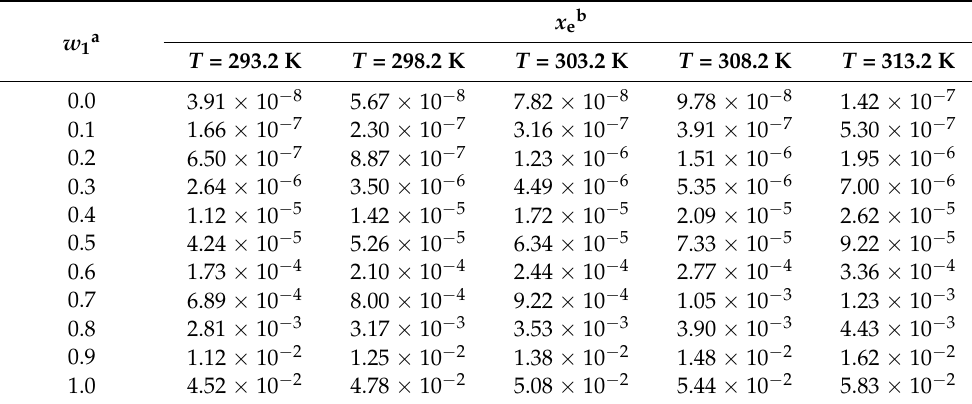
Table 1. Solubility values ( x e ) of cinnarizine (CNZ) in mole fraction (3) in binary {Transcutol-P (TP) (1) + water (2)} combinations from 293.2–313.2 K and at 0.1 MPa a .